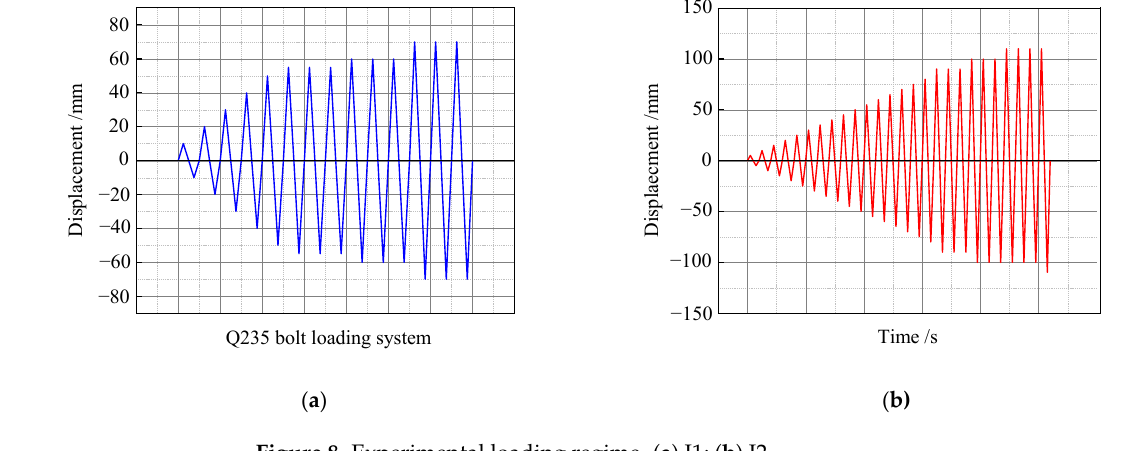
Figure 8. Experimental loading regime. ( a ) J1; ( b ) J2.